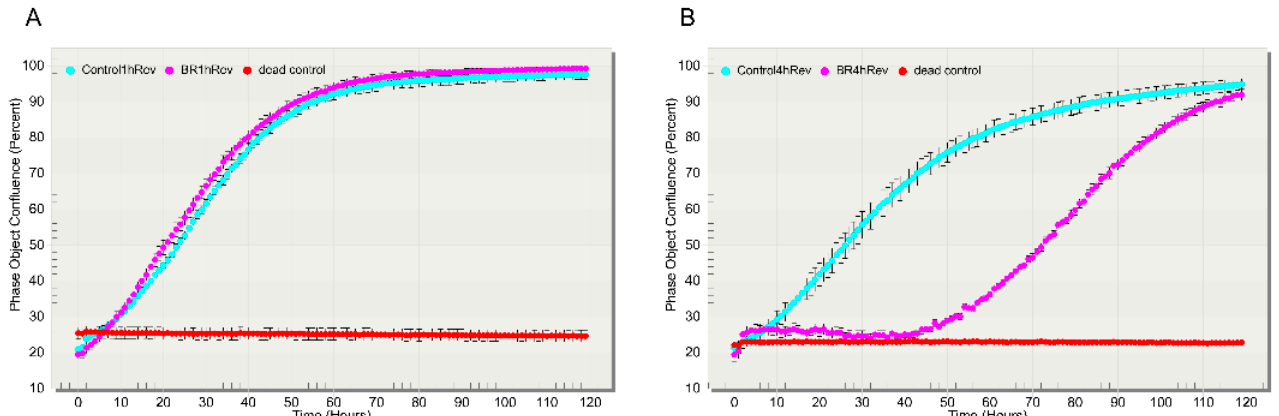
Figure 5. Growth curves depicting the dynamics of cell proliferation after lathanoid treatment (purple line) for 1 h BR1hRev ( A ) and 4 h BR4hRev ( B ) in comparison with control (cyan line) and dead control (red line).